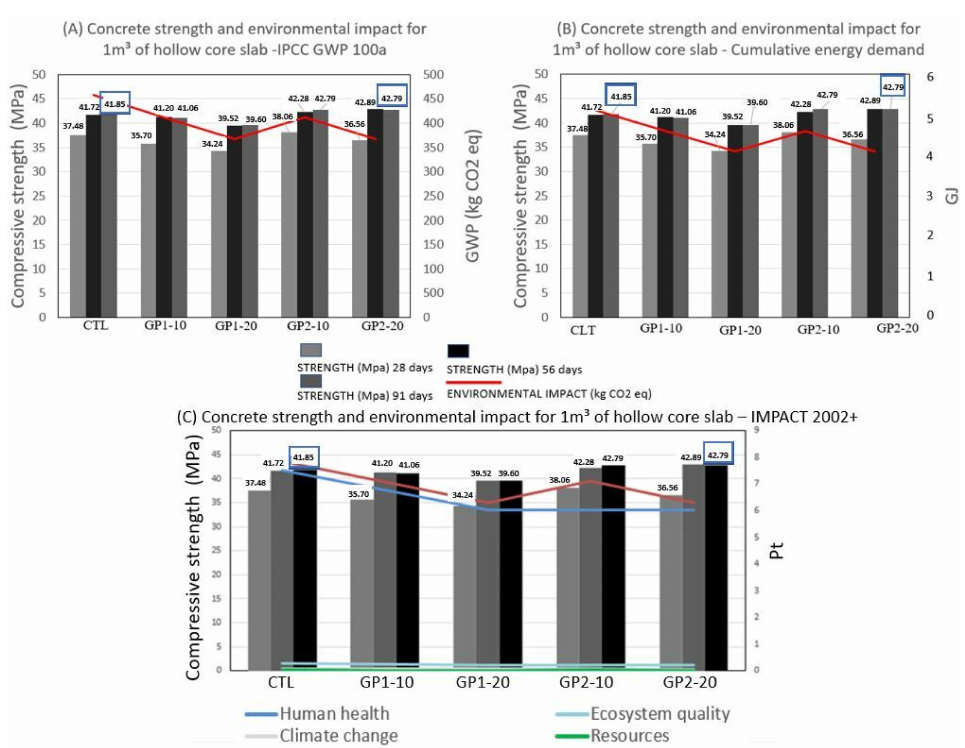
Figure 14. Compression strength versus environmental impact: ( A ) GWP; ( B ) embodied energy (EE); ( C ) total impact indicator